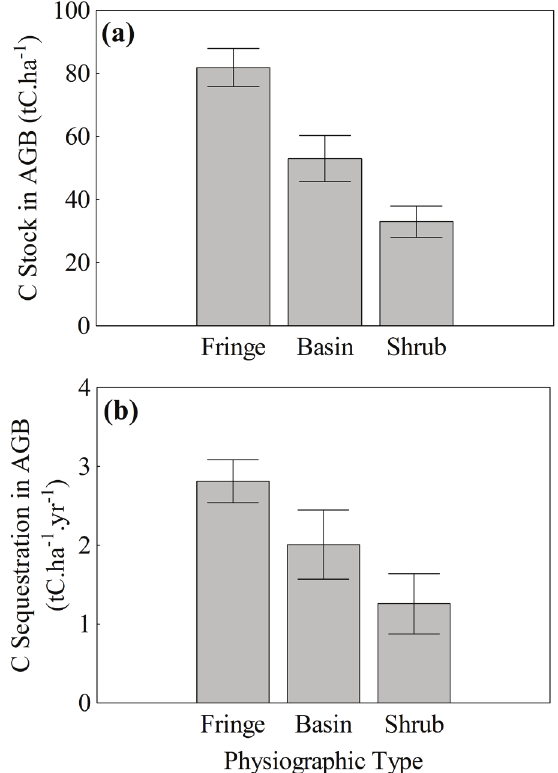
Figure 4 - Carbon stock ( a ) and sequestration ( b ) in the aboveground biomass (AGB) per physiographic type (mean ± standard error). The letters a-c indicate significant differences. There are significant differences only for carbon stock (ANOVA: F = 132.5, p < 0.01), although the Tukey post-hoc test did not indicate significant differences between basin and shrub forests ( p = 0.30). In the other cases, the probability is always lower than